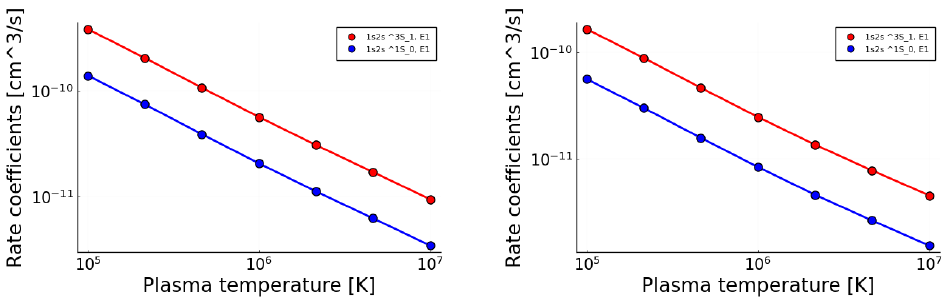
Figure 6. The same as in Figure 4 but for the capture into the initially excited i = 1 s 2 s 3 S 1 and 1 s 2 s 1 S 0 levels. Data are shown for the total RR plasma rate coefficients α ( RR ) ( T e , i ) for these two levels (left panel) as well as for just the capture into the 1 s 2 2 s and 1 s 2 s 2 configurations (right